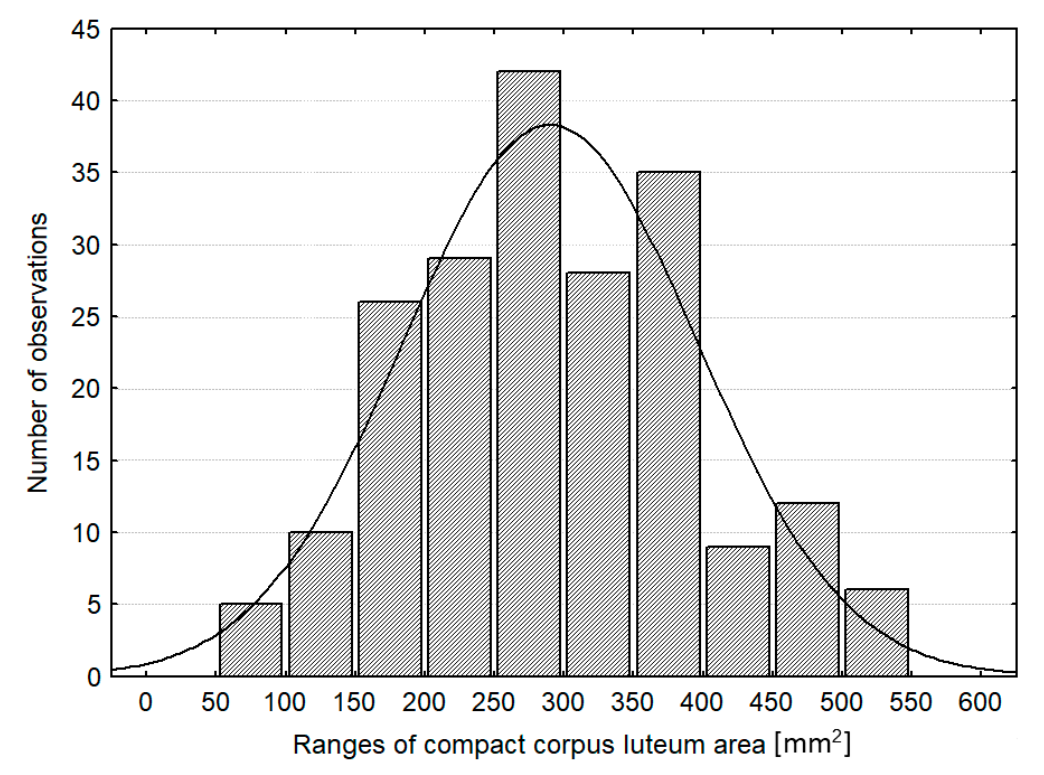
Figure 3. The number of observations in adopted size ranges of compact CLs; CL: corpus luteum.